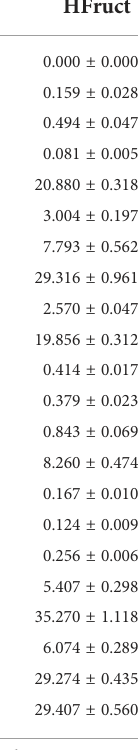
Values represent mean ± SEM for fi ve to seven mice per experimental group. a p<0.05 vs. Chow; b p<0.05 vs. HFat. Monounsaturated fatty acids (MUFAs) correspond to C16:1n7, C18:1n9, C18:1n7, and C20:1n9. n-3 polyunsaturated fatty acids (PUFAs) correspond to C18:3n3, C22:5n3, and C22:6n3; n-6 PUFA correspond to C18:2n6, C20:3n6, C20:4n6, C22:4n6, and C22:5n6. Saturated fatty acids (SFAs) correspond to C10:0, C12:0, C14:0, C15:0, C16:0, and